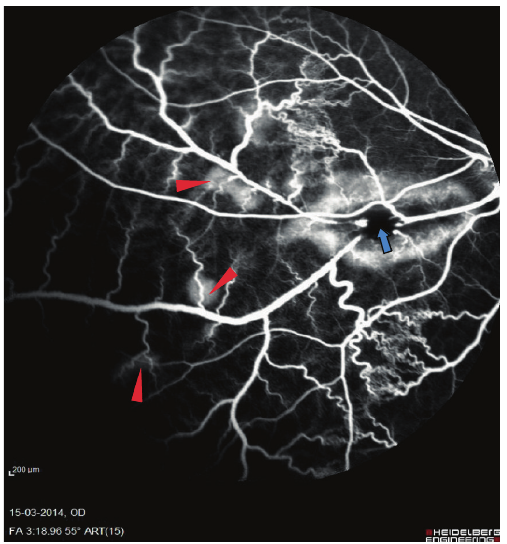
Figure3:Shuntingofbloodfordrainagebyadjacentveins.Shunting of blood to adjacent veins is marked with red triangle. The site of occlusion is marked with blue arrow.